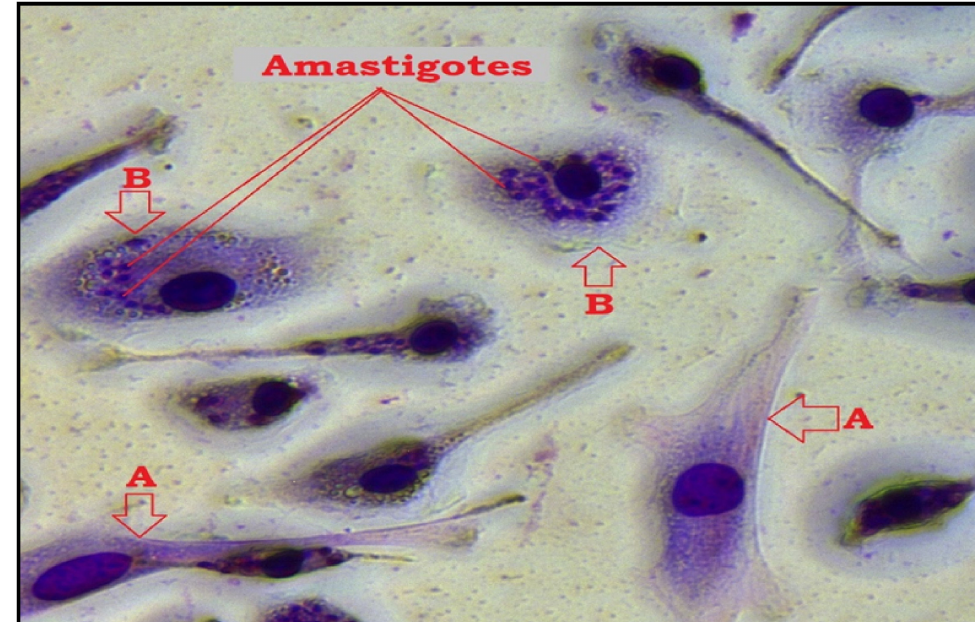
Figure 4. Microscopic image of macrophage infection by L. major after TQ treatment and Giemsa staining using 40 × objective (Leica MCD-400). ( A ); uninfected macrophage, ( B ); infected macrophage while amastigotes appear as darkly stained blue particles in the